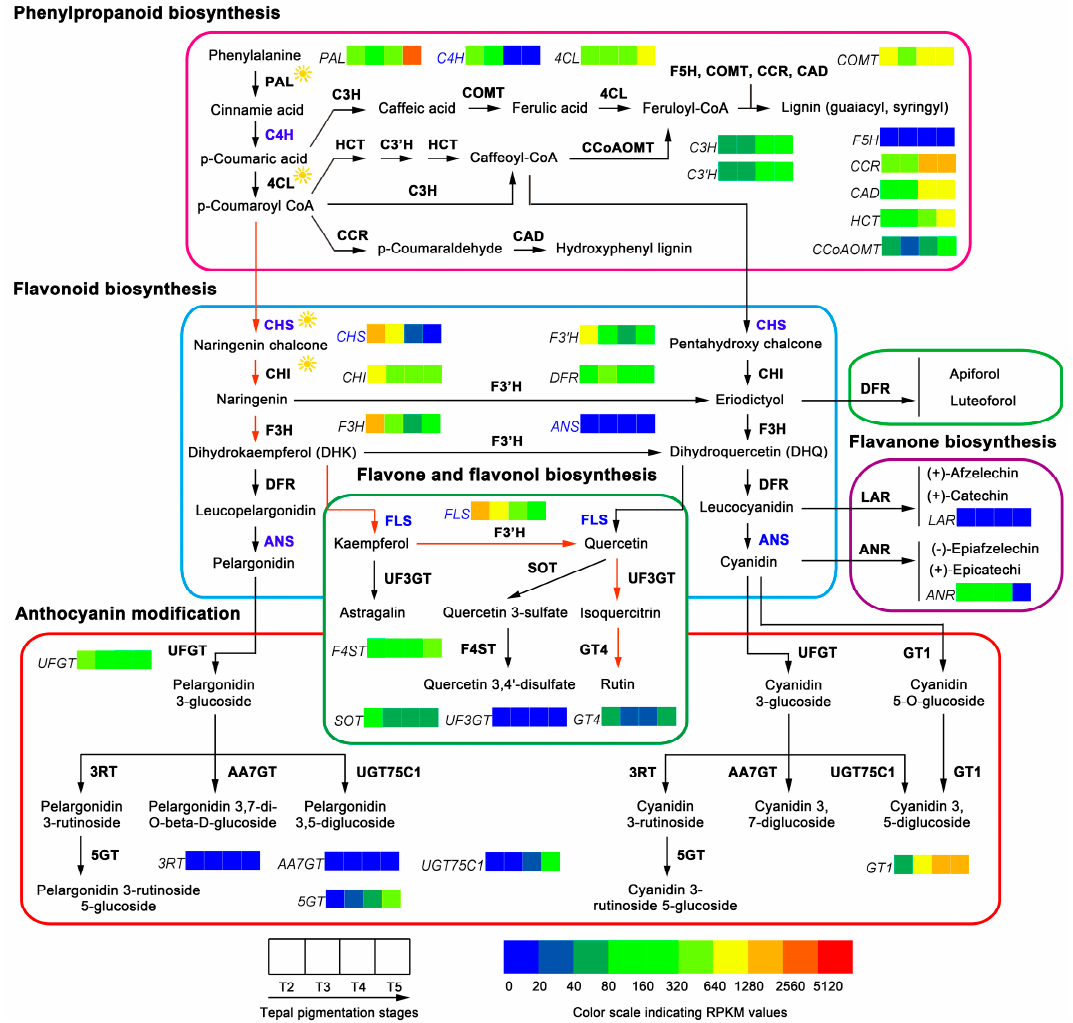
Figure 5. Flavonoids metabolic pathway in tepals of Chinese narcissus and gene expression changes during tepal pigmentation process. The pathway is divided into five sub-pathways based on the functions of unigenes. The additive expression changes of unigenes at different tepal pigmentation stages (T2, T3, T4 and T5) are shown by color grids based on RPKM value. The presumed critical genes C4H , CHS , ANS , and FLS in the pathway are marked with blue color. Black filled arrows indicate the substance metabolism directions; red filled arrows indicate the main flux (from naringenin to rutin) of flavonoids metabolic pathway in tepals. Enzymes marked with sunlight indicate their catalytic activities can be influenced by light.